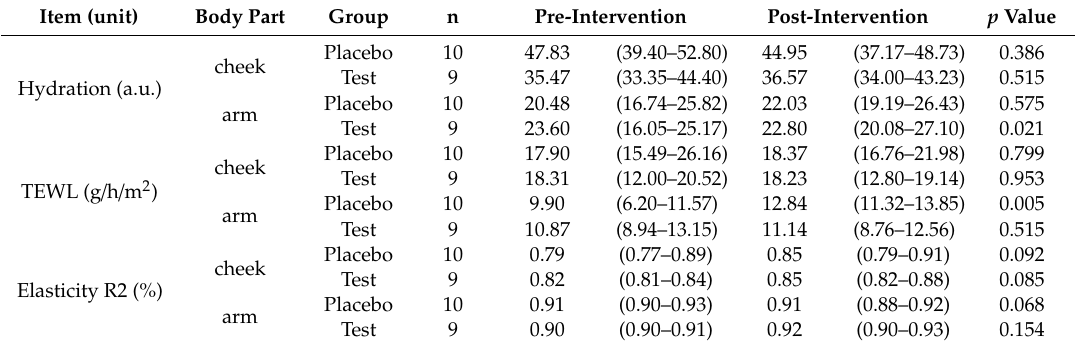
Table 3. Comparison of skin item values pre- and post-